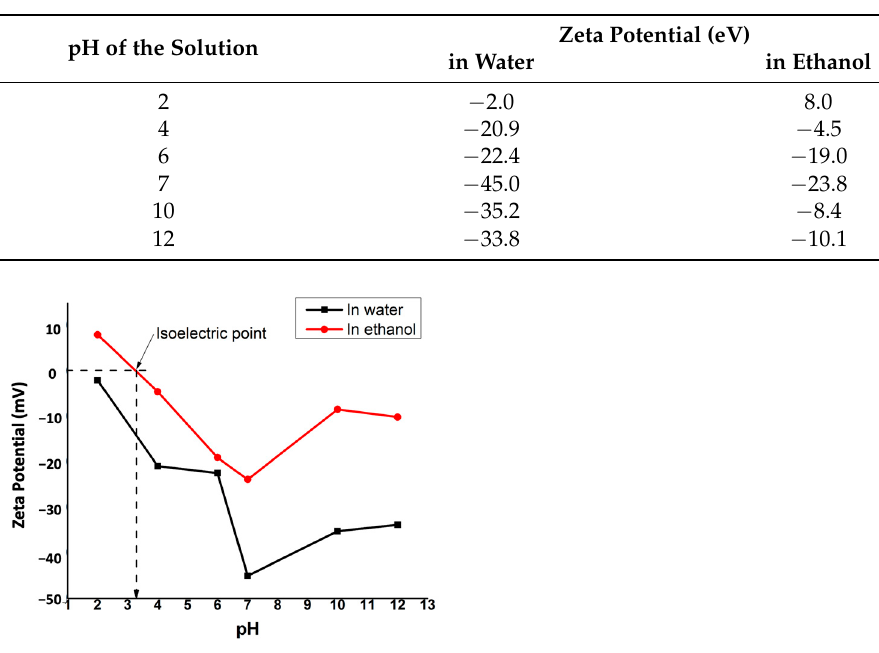
Figure 4. Zeta potential vs. pH of Fe(III)-TA colloids in water and